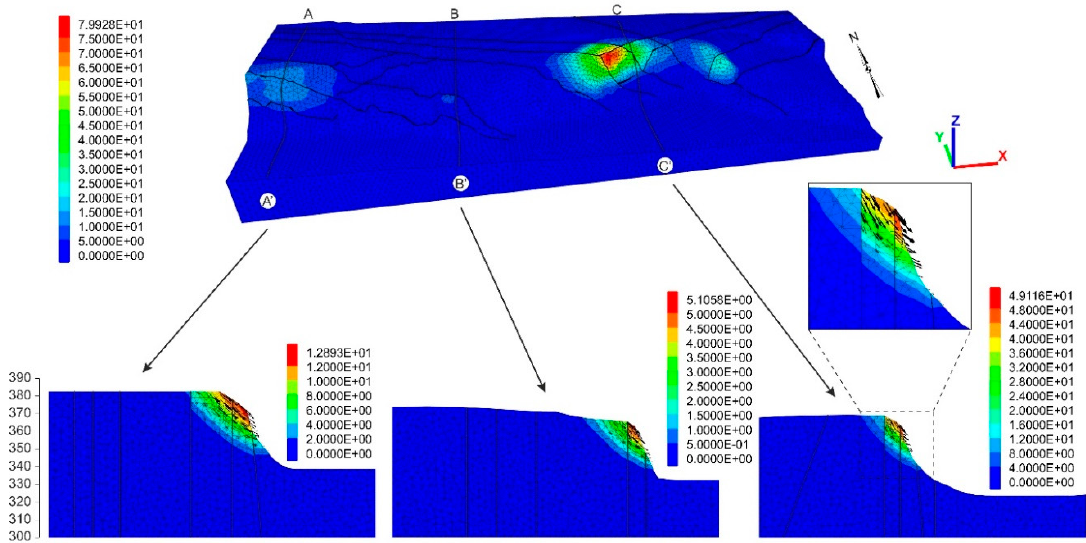
Figure 19. Contour displacements and displacement vectors (sections) of the pre-landslide model with discontinuities.